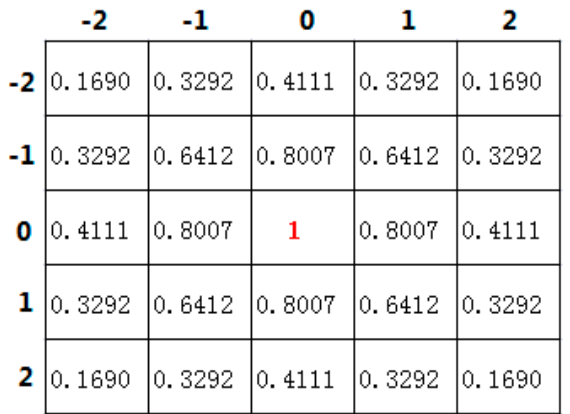
Figure 4. Distribution of Gaussian space weight. 3.4. Line Space Voting Scheme After extracting the line segments from the input image and removing the invalid line segments, a line space voting scheme is used to detect the vanishing point. This voting scheme uses the points on the lines and the points in their 5 × 5 neighborhood space to vote for the VP with the length, orientation, and Gaussian space weight. The method ignores the other pixels, thereby greatly reducing the number of voters, so that it can improve the detection speed of the VP. Moreover, some